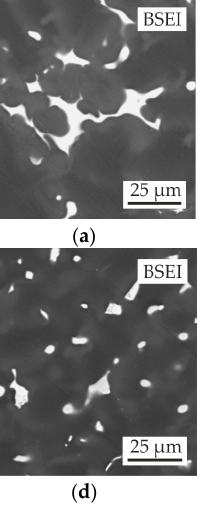
Figure 4. Microstructure and EDS maps of the ( a – c ) MgZn4Ga4 and ( d – g ) MgZn4Ga4Y0.5 alloys in the as-cast condition. The EDS maps showing the distribution of ( b , e ) Zn, ( c , f ) Ga, and ( g ) Y.